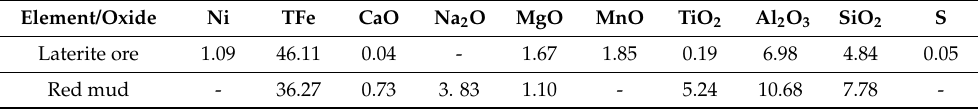
Table 1. Results of the main chemical element/oxide analysis on the laterite ore and red mud (wt%). Element/Oxide